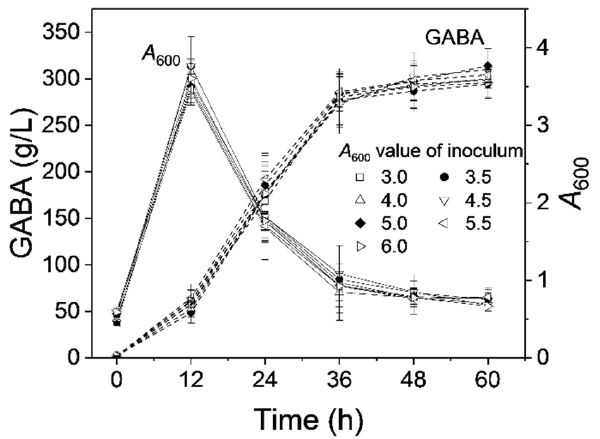
Figure 7. The effect of seed age on GABA production and cell growth. This was evaluated using a 250 mL Erlenmeyer fermentation flask at 30.0 °C. Fermentations were performed using inocula with different A 600 values, which were prepared from the seed media containing 10 g/L glucose. Cell growth was expressed as A 600 . Vertical bars represent standard deviations of means ( n = 3). There was no significant difference in 48 h GABA concentration between the different treatments (inocula different A 600 value; p = 0.979). GABA, gamma-aminobutyric acid; A 600 , absorbance at 600 nm.